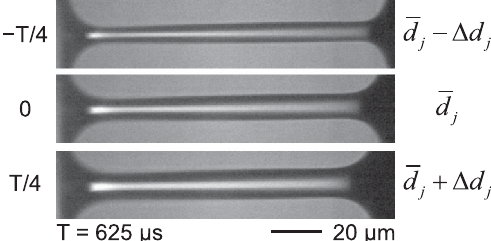
FIG. 3. The forced oscillation of the cone-jet bridge, in which the average diameter along the jet ( d j ) fluctuates with a period ( T ). The oscillation was driven by a sinusoidal voltage at 1.6 kHz with a peak-to-peak amplitude of 20 V, superimposed on the base voltage of 2.4 kV. The flow rate of ethylene glycol ( 5 : 2 (cid:1) S = cm ) was 0 : 2 mL = h , and the nozzle-to-plate separation was 0.2 mm. A long nozzle (20 mm) was used to promote oscillations, as discussed in Sec. II. These snapshots, spanning half a period, were captured from the top half of Video 2 [26].